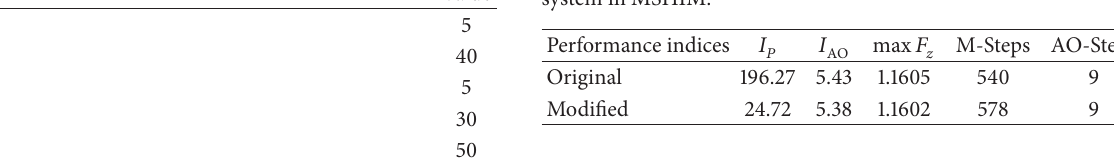
Table 1: Parameters of the power control system simulation. Parameters